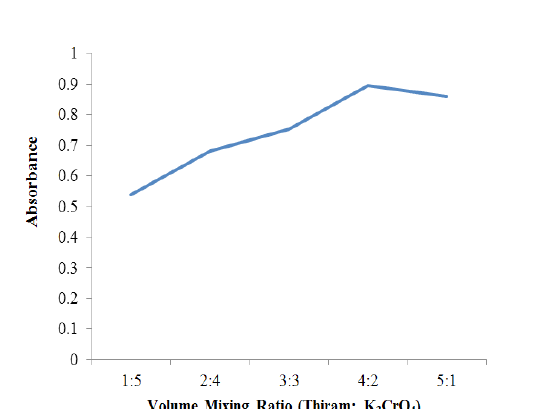
CrO (Concentration of thiram and K 2 4